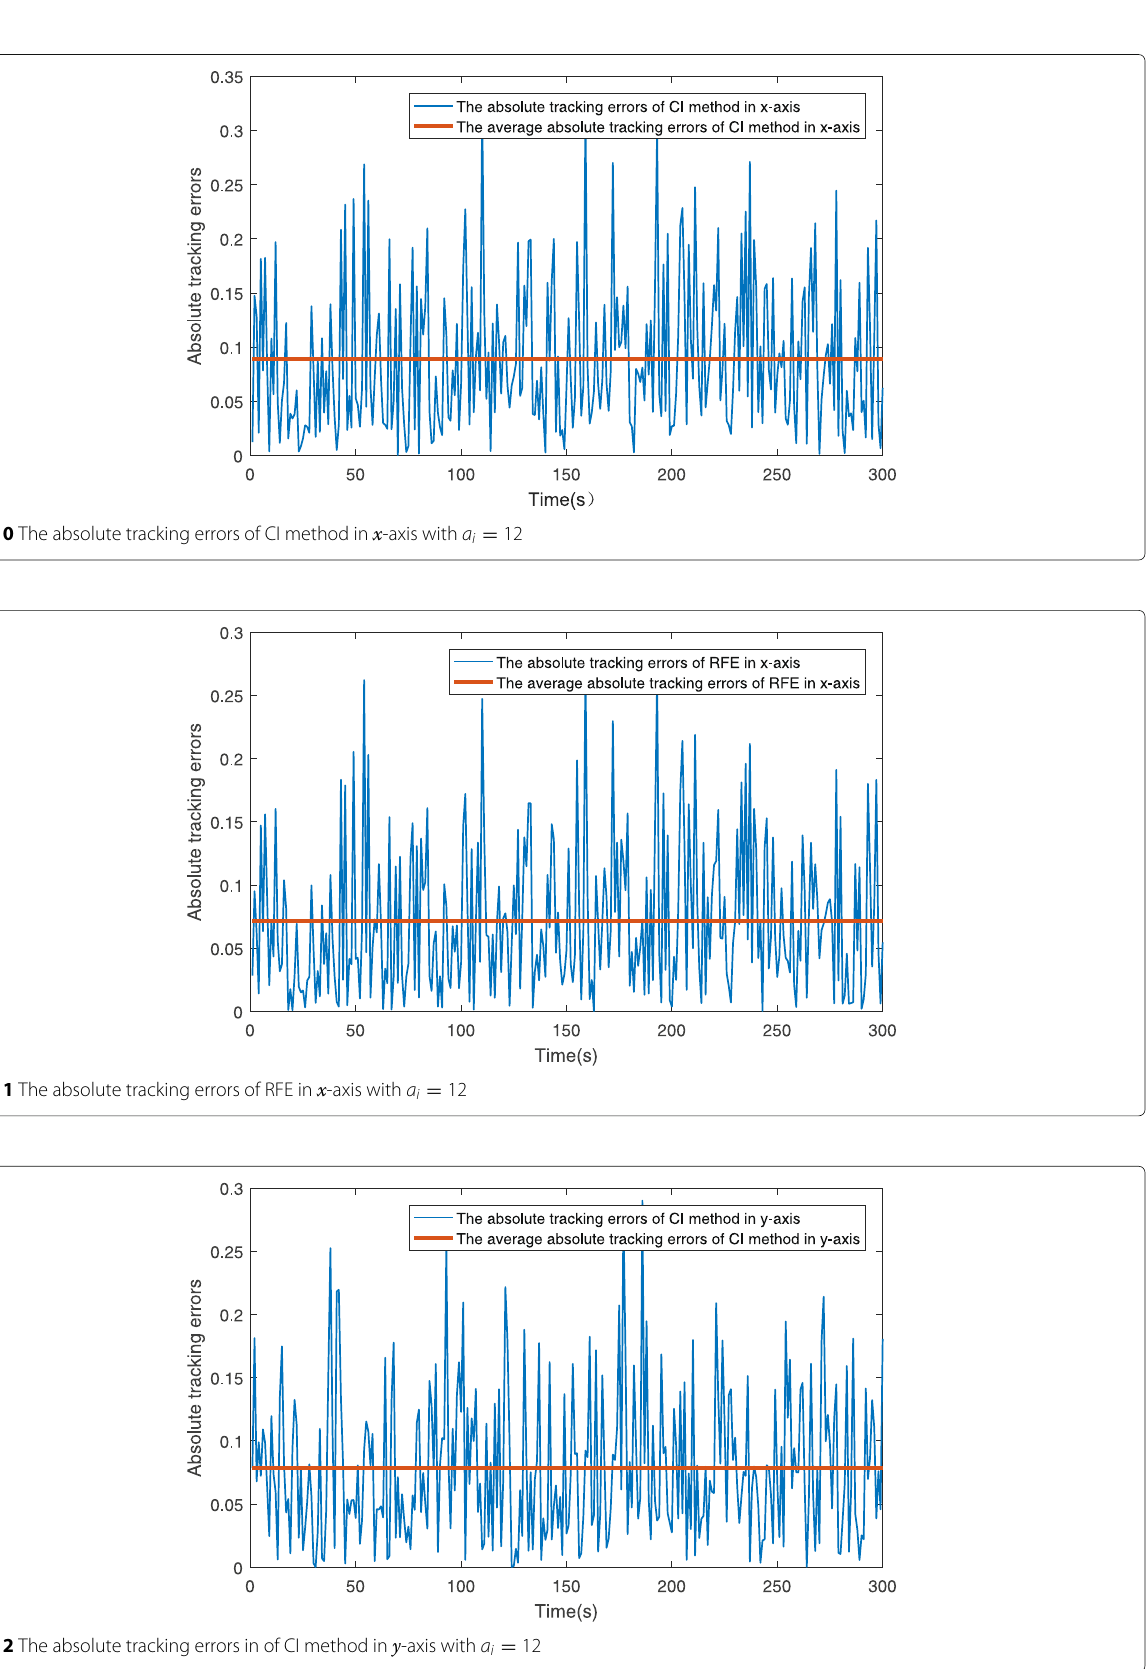
Fig. 12 The absolute tracking errors in of CI method in y -axis with a i =